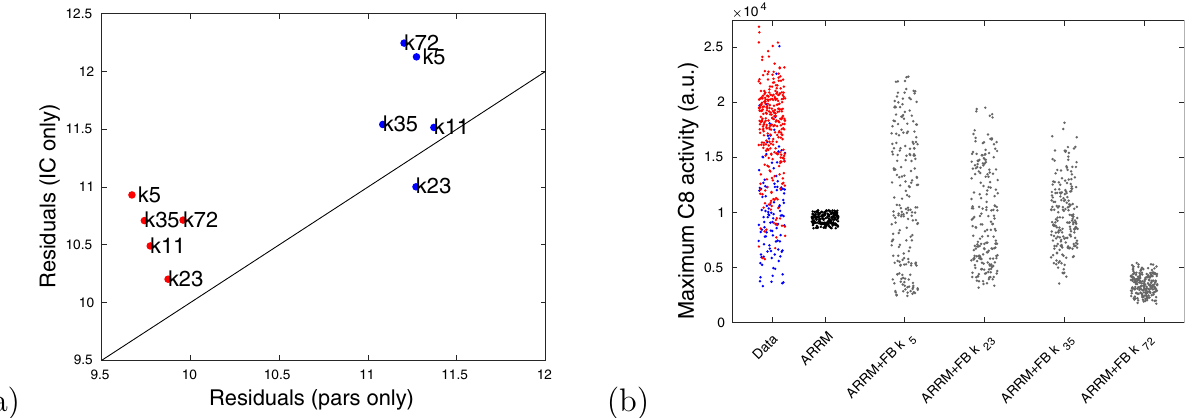
Figure 5. Comparison of different ARRM+Feedback configurations. ( a ) Average residuals for the feedbacks, k i ( C 8 ) . Each configuration was fitted to all 414 cells, first estimating all parameters (“pars” only, x -axis) and then fixing the parameters at those of a universal cell and estimating all initial conditions (IC only, y -axis). Red and blue dots represent average residuals among sensitive and resistant phenotypes, respectively. The straight line represents the points y = x ; ( b ) The maximal C8 activity (maximal slope of C8 Reporter FRET signal) generated by each configuration, in response to 20% variation in initial conditions (200 simulated cells randomly generated for each